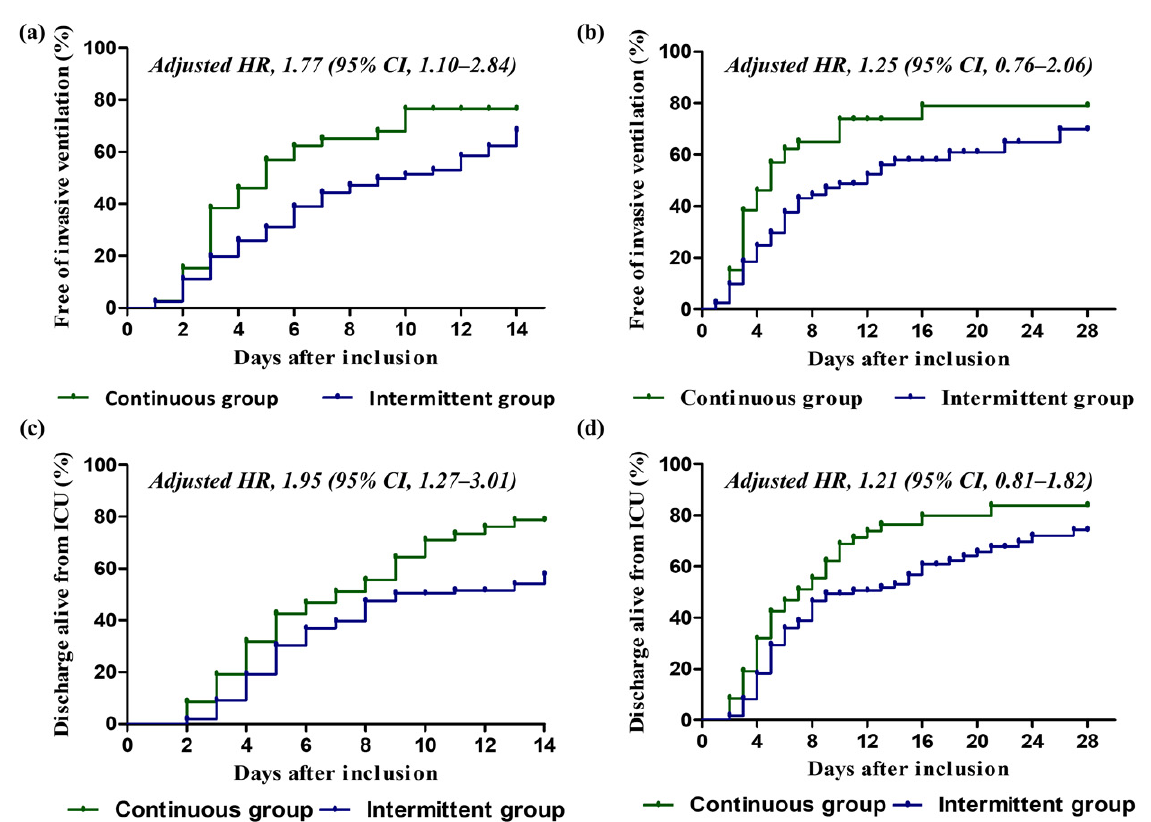
Figure 3. Cumulative incidence functions for patients in the continuous and intermittent groups. ( a ) Rate of freedom from invasive ventilation at 14 days. ( b ) Rate of freedom from invasive ventilation at 28 days. ( c ) Rate of discharge alive from ICU at 14 days. ( d ) Rate of discharge alive from ICU at 28 days. Continuous group (green) and intermittent group (blue) are displayed, and hazard ratio and 95% confidence interval are provided, of which a ratio of more than 1.00 indicates a higher probability of discharge alive from ICU or freedom from invasive ventilation in the continuous group than in the intermittent group. For each panel, adjusted models were performed by Cox hazard regression analysis. Co-variable selection was based on statistical significance and/or associations in the scientific literature. HR, hazard ratio; CI, confidence interval; ICU, intensive care unit. Table 3. Clinical outcomes according to the type of infusion of piperacillin/tazobactam. Outcome